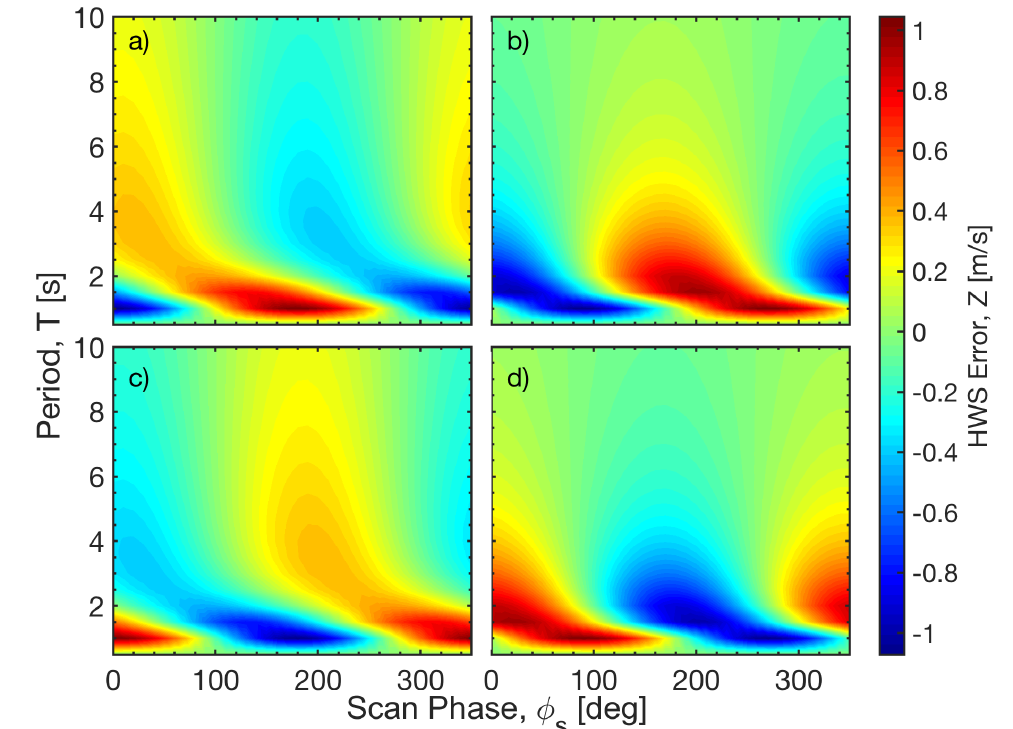
Figure 1. Simulated horizontal wind speed (HWS) error, Z (Equation (1)), under roll-only motion as a function of velocity-azimuth-display (VAD) scan phase ( x -axis) and motional period, T , ( y -axis). Roll phase ( φ r ) is equal to 0 deg ( a ), 90 deg ( b ), 180 deg ( c ), and 270 deg ( d ). Roll amplitude is 3.5 deg, wind vector is ( 0,10,0 ) m/s, and measurement height is 100 m in all panels